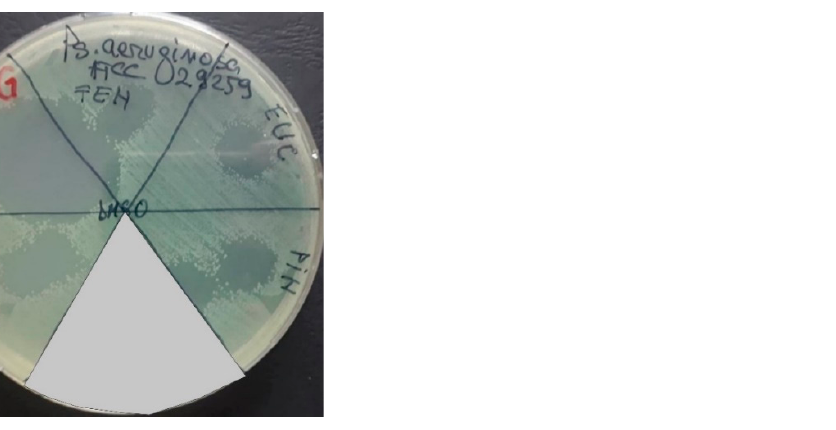
Figure 4. The aspect of the inhibition zones expressed by the Gram-negative strains Pseudomonas aeruginosa ATCC 27853 in the presence of tested EO at 1/10 dilution in DMSO; FEN (fennel EO); SV (sage EO); EUC (eucalyptus EO); CI (thyme EO); PIN (pine EO).